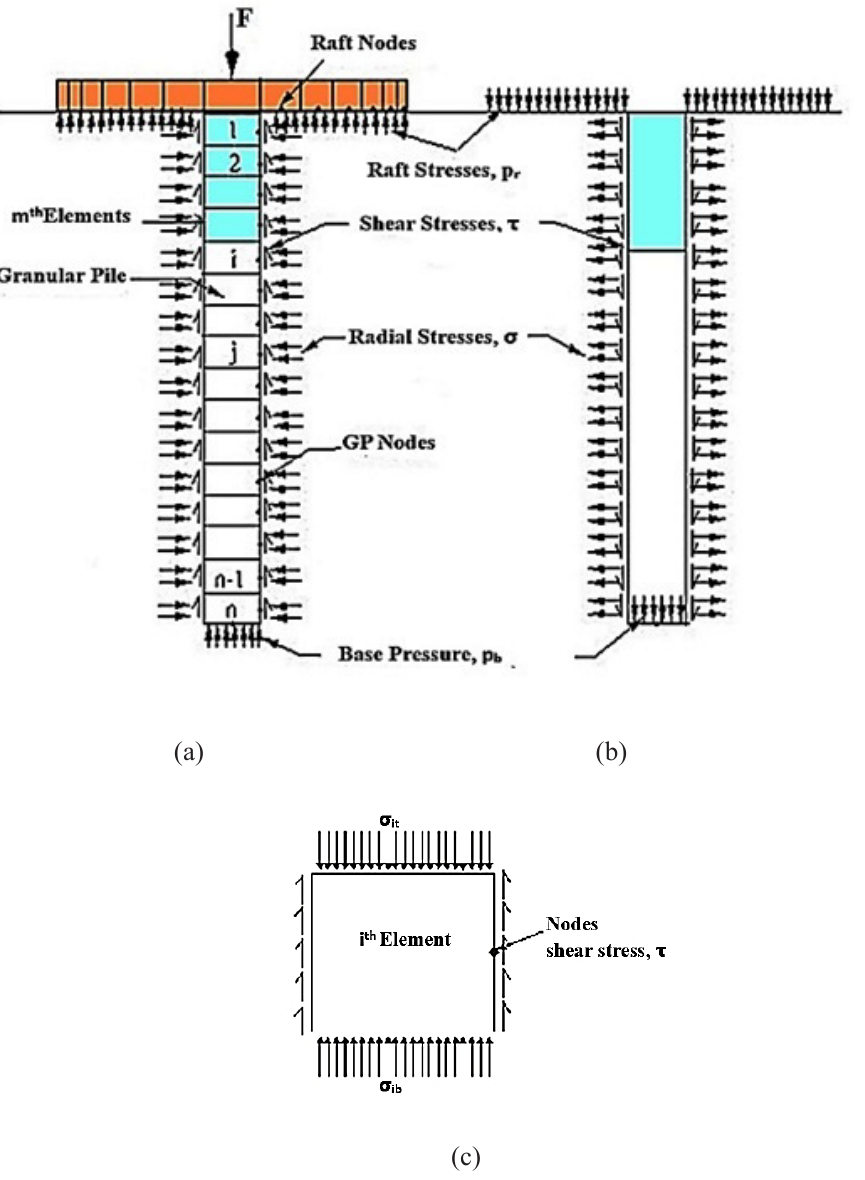
Figure 2: (a) Stresses on the GP and raft due to soil. (b) Stresses in the soil due to GP and raft. (c) Stresses on any i th element of the